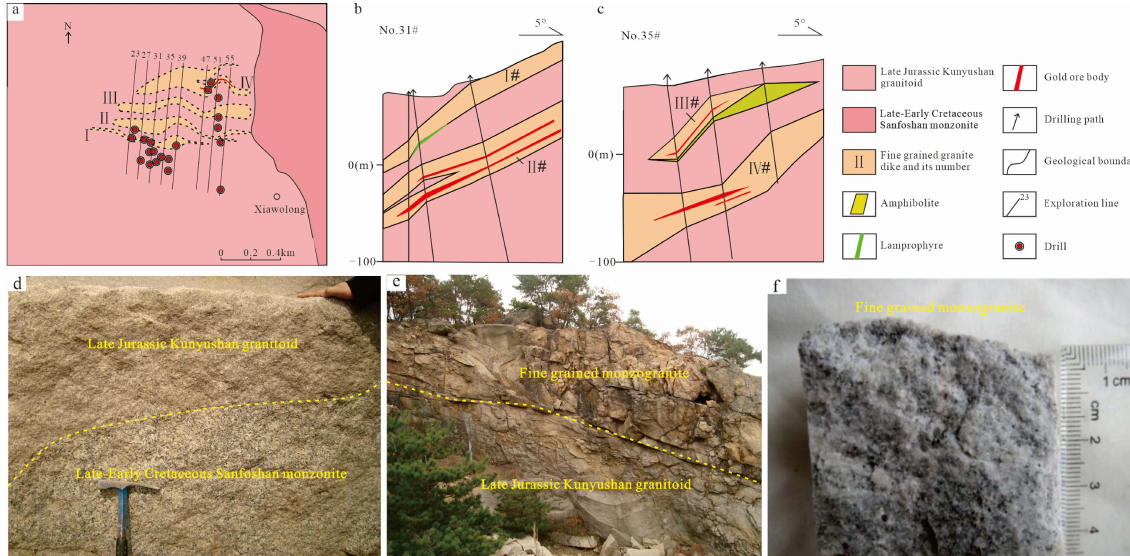
Figure 3. ( a ) Geological map of the Xiawolong gold deposit. ( b ) No. 31# and ( c ) No. 35# prospecting line profile of the Xiawolong gold deposit. ( d ) The abrupt contact between the medium- to coarse- grained monzogranite and medium- to fine-grained monzonite. ( e ) The abrupt contact between the medium- to coarse-grained monzogranite and the fine-grained granite dike. ( f ) Unaltered fine- grained